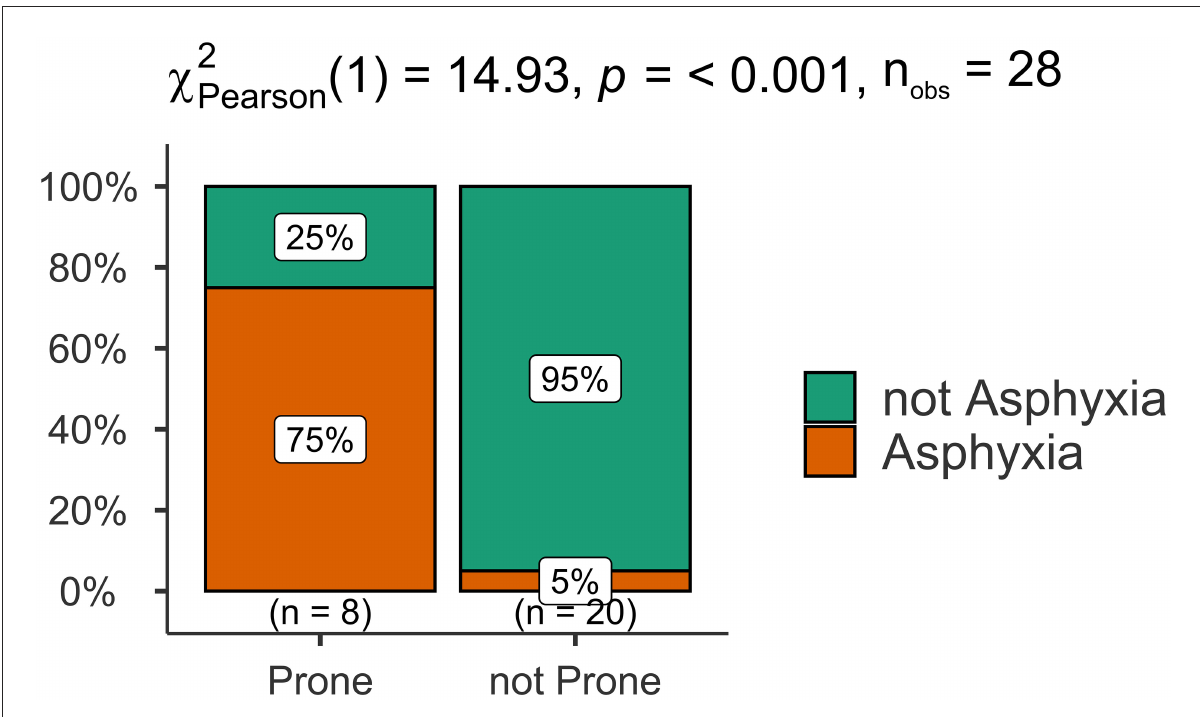
FIGURE5 Comparison of the signs of asphyxia between prone and not-prone